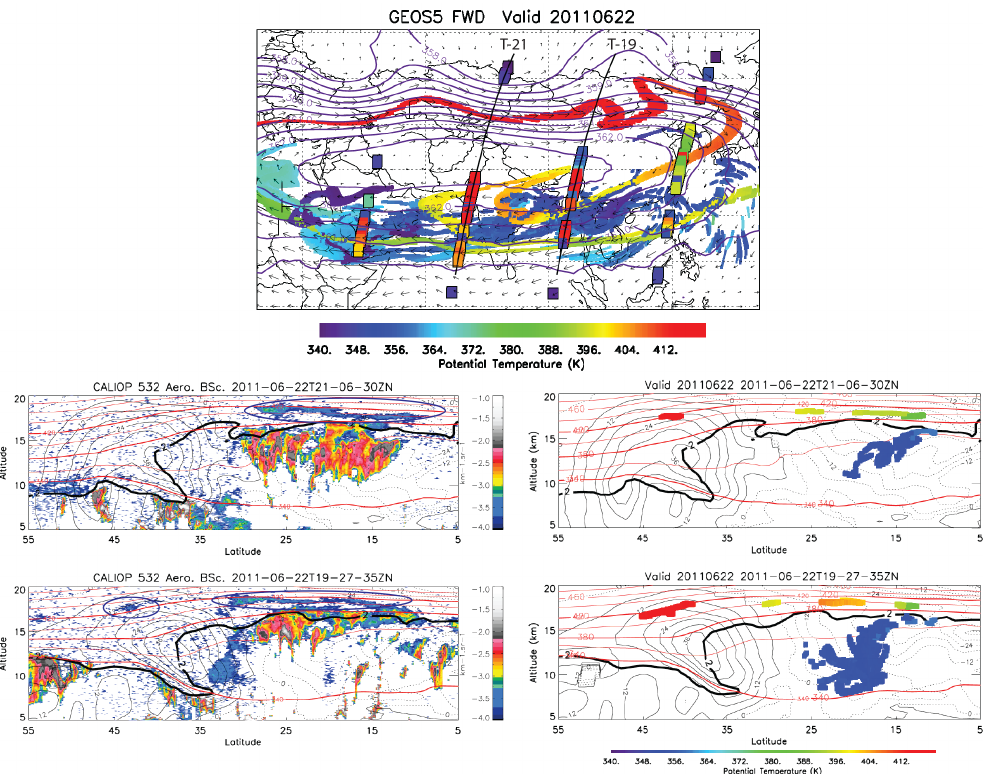
Figure 5. As for Fig. 3, but for 18:00Z–midnight on 22 June, with 532nm attenuated aerosol backscatter curtains, and coincident trajectory curtains for CALIPSO nighttime orbits T21-06-30ZN and T19-27-35ZN, marked by back curves on